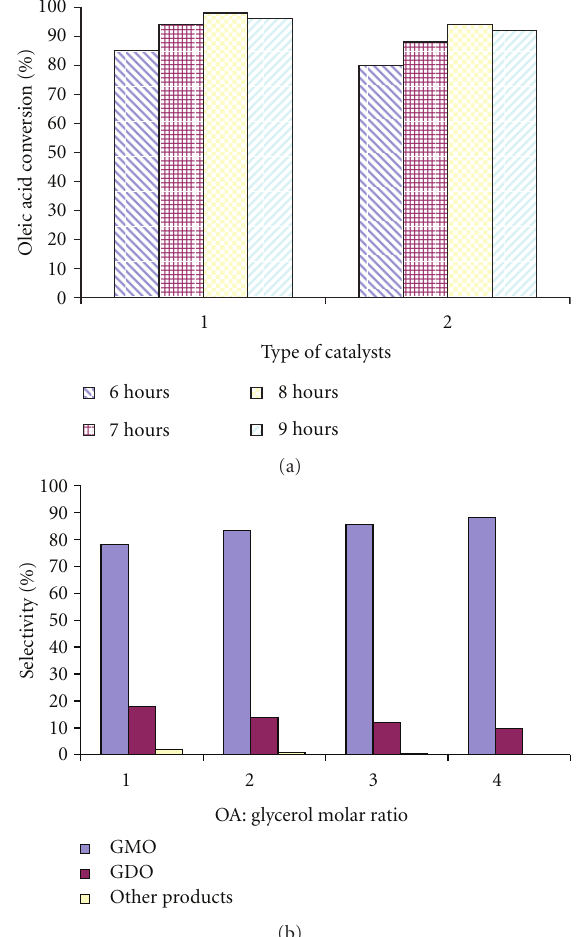
Figure 8: Catalytic activity in the esterification reaction (a) reaction time versus conversion for types of catalysts and (b) AO: glycerol molar ratio versus selectivity using STA-SG as the